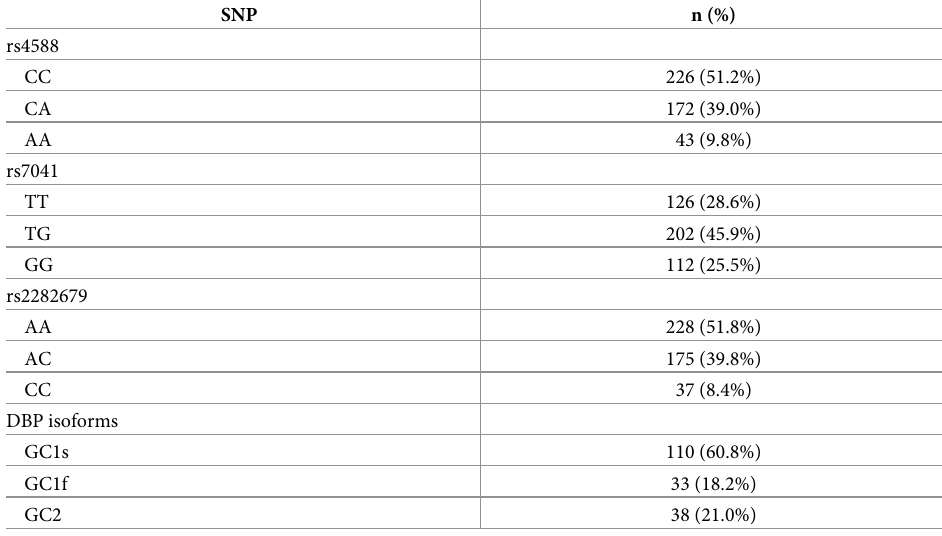
Table 2. GC gene polymorphisms and DBP isoforms